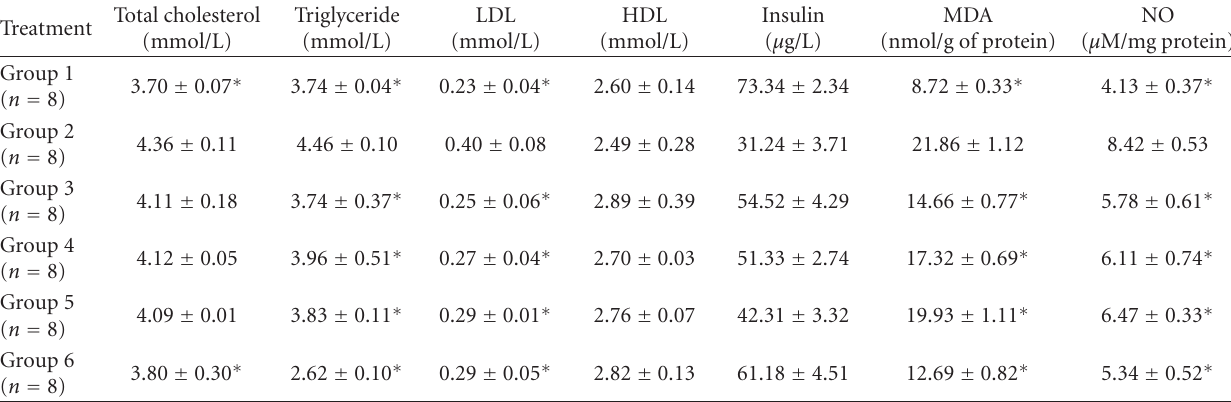
Group 1: normal control; Group 2: diabetic control; Group 3: diabetic + M. charantia extracts (200mg/kg); Group 4: diabetic + nonfermented mung bean extracts (1000mg/kg); Group 5: diabetic + fermented mung bean extracts (200mg/kg); Group 6: diabetic + fermented mung bean extracts (1000mg/kg). ∗ P > 0.05 versus group 2 (diabetic control).